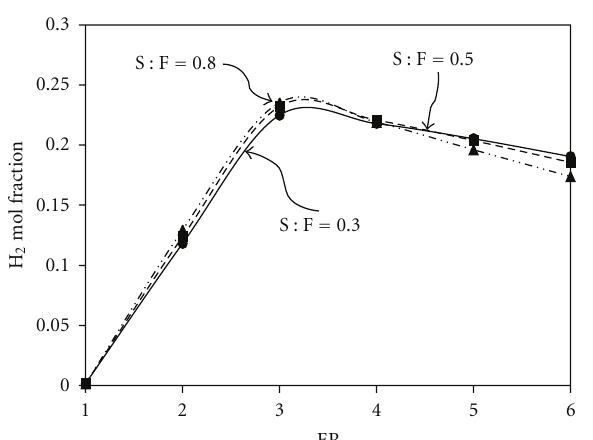
Figure 5: E ff ect of ER on H 2 production for various S :F, estimated with chemical equilibrium.